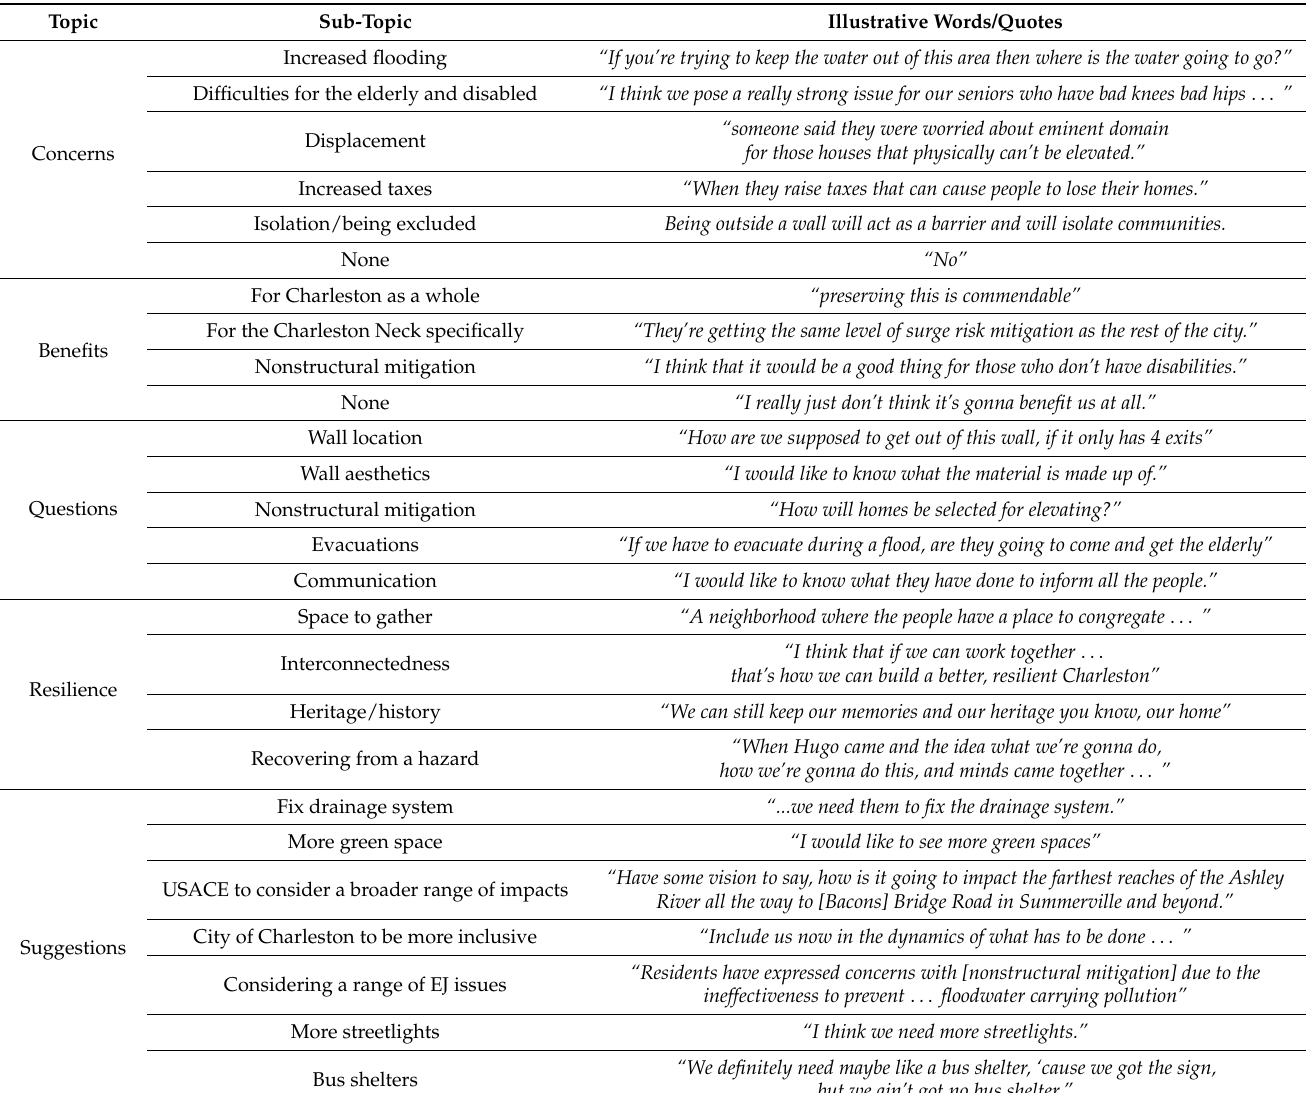
Table 4. Illustrative quotes for responses prompted by discussion about the proposed seawall. We use italics throughout the paper to clearly identify quotes from study